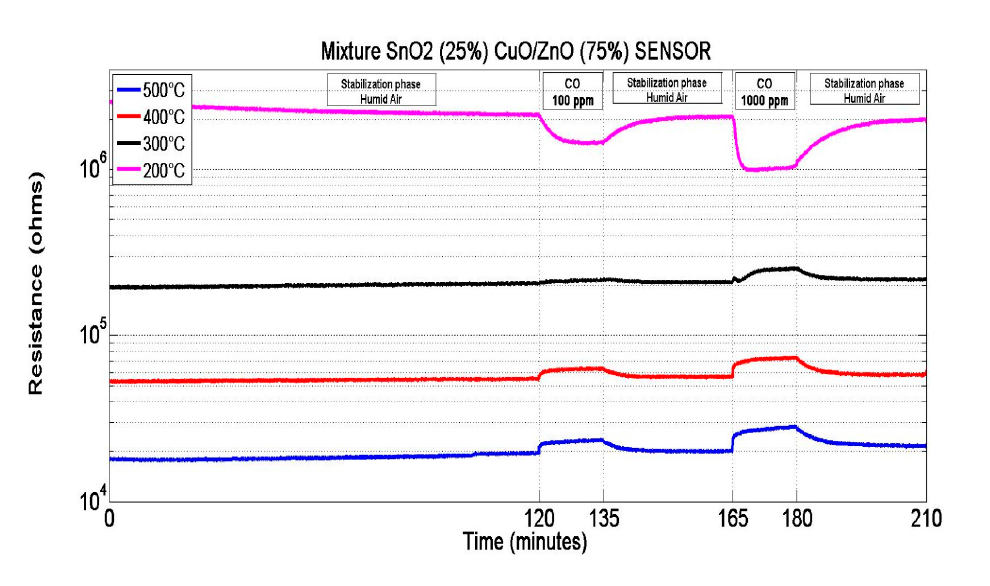
Figure 4. Responses of gas sensor at different operating temperatures for the MOS: mixture SnO 2 (25%) and CuO 75% /ZnO 25%